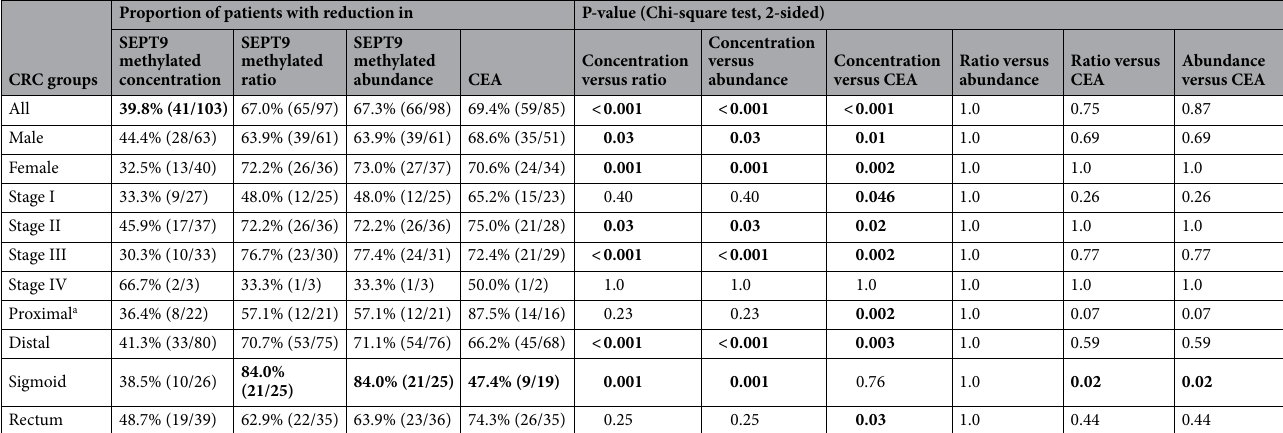
Table 3. The proportion of patients with reduction in SEPT9 methylation and CEA levels 3-month post- operation. Significant values are in bold. SEPT9 septin 9, CEA carcinoembryonic antigen, CRC colorectal cancer. a Proximal referred to cancer above the splenic